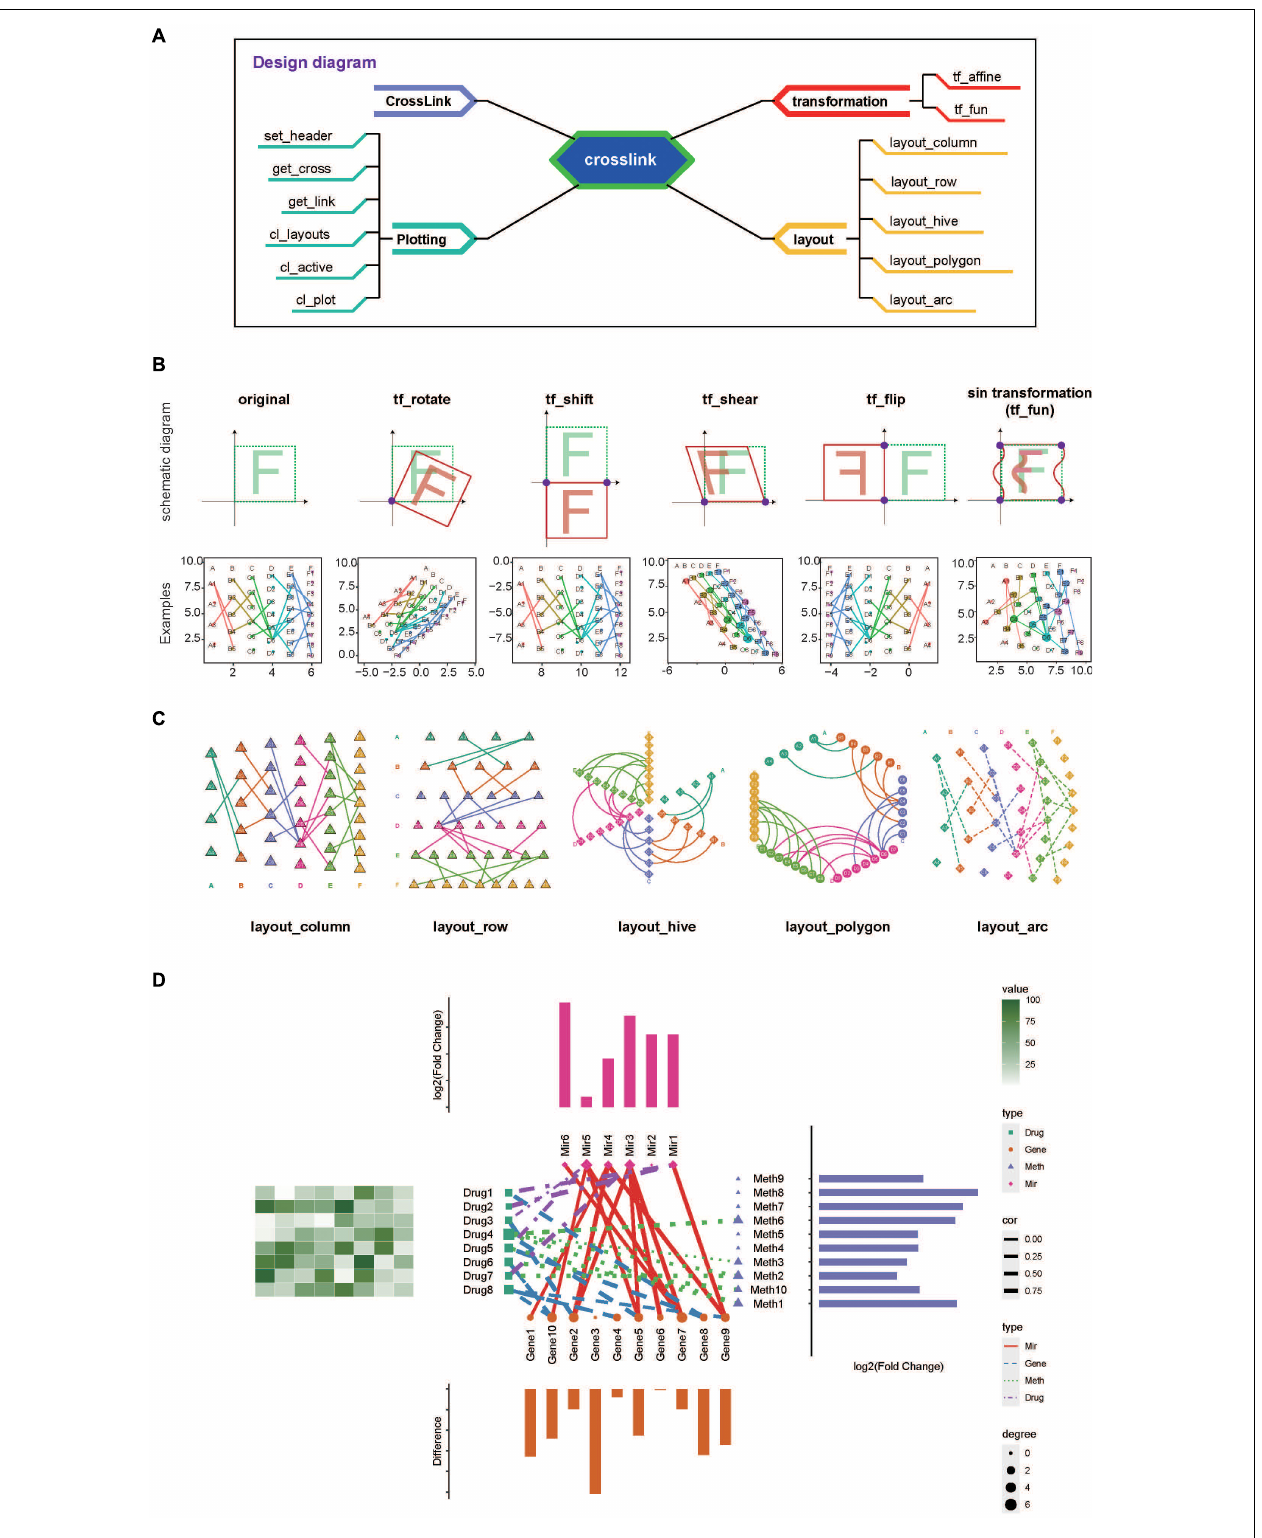
FIGURE 1 | Overviw and usage examples of crosslink. (A) . A schematic diagram of crosslink showing four modules and associated functions. (B) Schematic diagram and examples showing transformation effects after using the coordinate transformation functions as indicated. (C) Examples of five predefined layout styles. (D) A typical application of combination network visualization by using